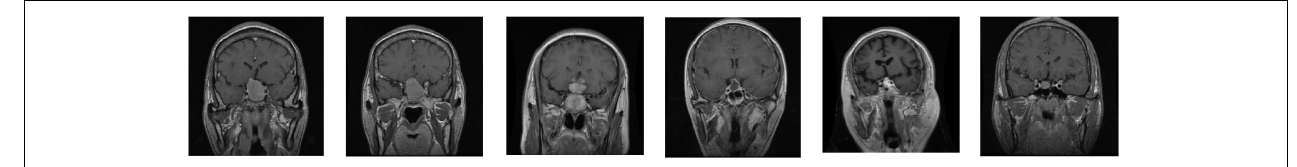
FIGURE 4 | Retrieval result examples of SRDML in Pituitary.